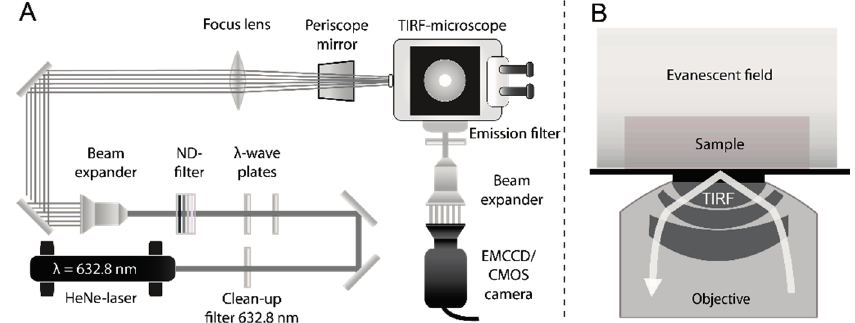
Figure 8. ( A ) Schematic of the TIRFM setup; ( B ) TIRF principle. Total internal reflection